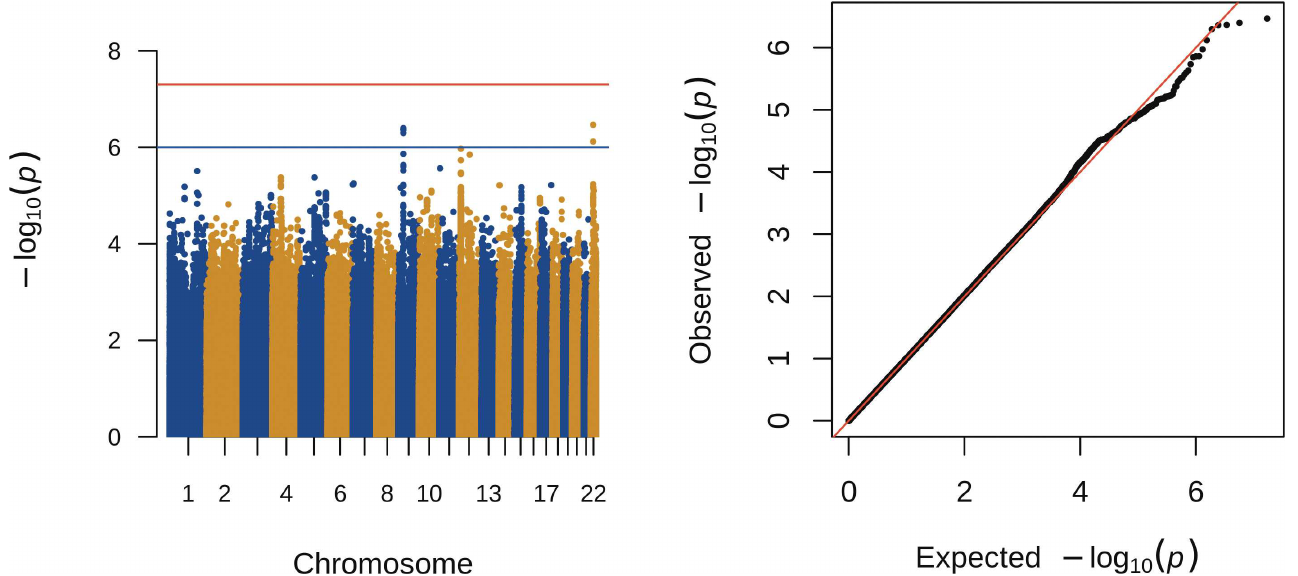
Fig 2. Association of genome-wide variants with plasma fT4 concentrations. SNPs that passed QC are plotted on the x-axis accordingto their chromosomal position againsttheir–log10( p -value).The results were consideredgenome-wide significantwith a p < 5 (cid:1) 10 − 8 and a replication threshold was set at p < 1 (cid:1) 10 − 6